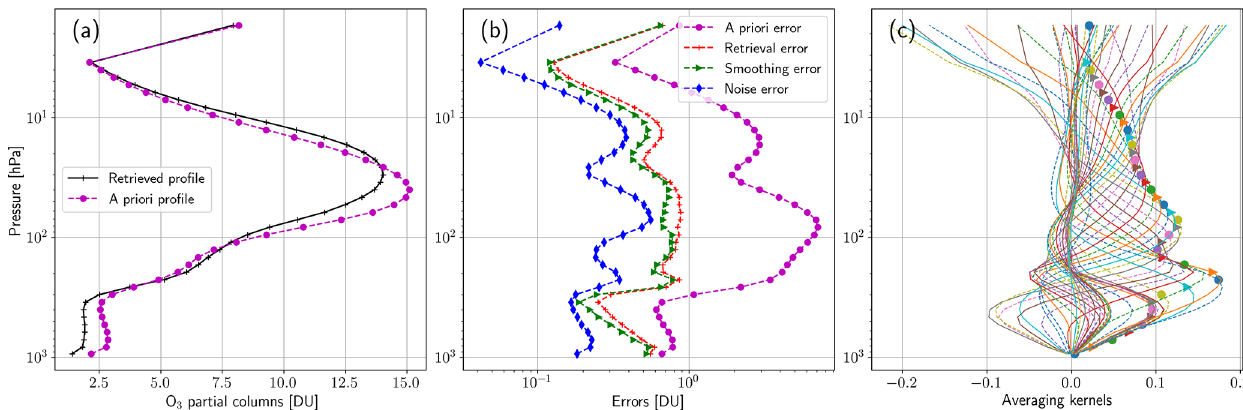
Figure 1. Panel (a) shows the retrieved ozone profile and the a priori profile, panel (b) shows the errors and panel (c) shows the averaging kernels of the IASI measurement. The dots in panel (c) represent the diagonal values of the AKM.